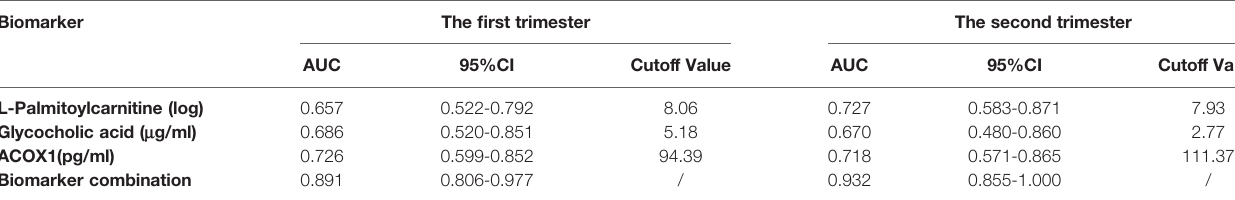
TABLE 5 | Predictive utility of serum biomarker levels among pregnant women with ICP in the fi rst and second trimesters. Biomarker The fi rst